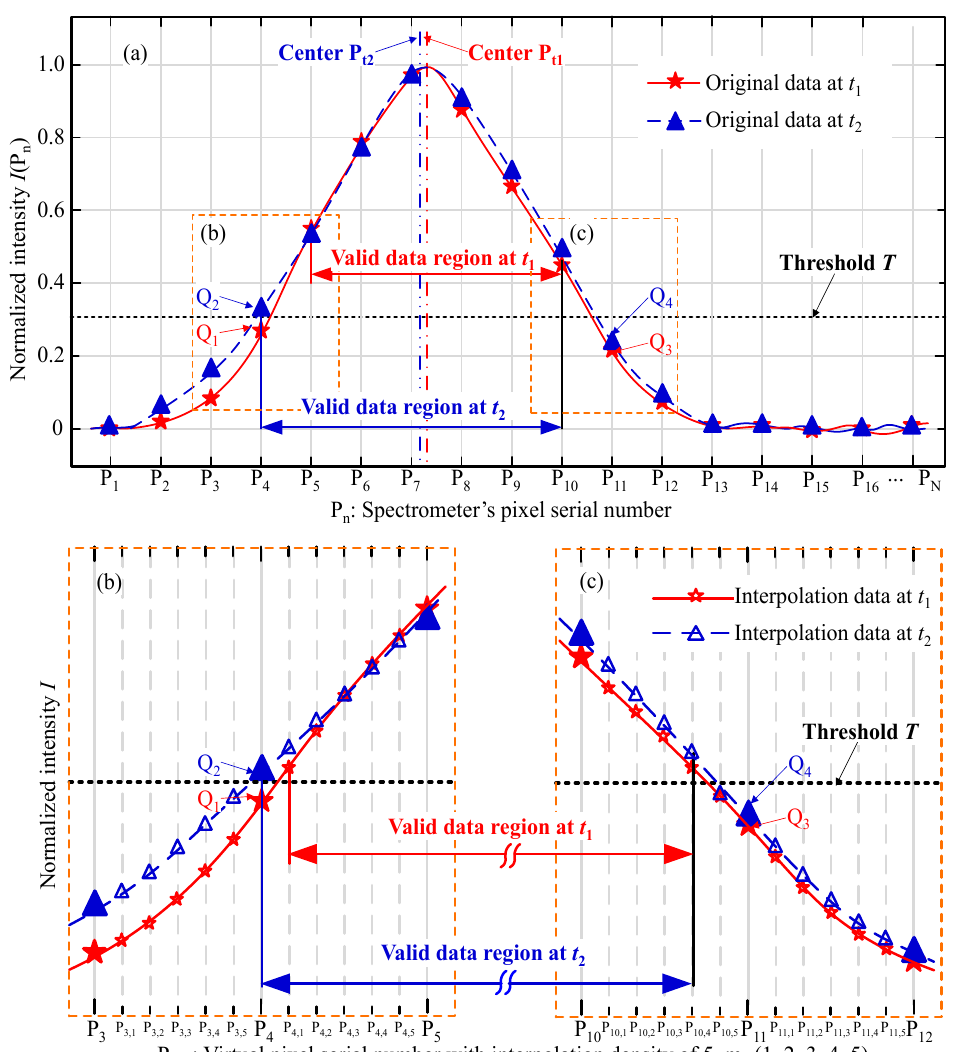
Figure 3. Schematic of the thresholding peak extraction algorithm.